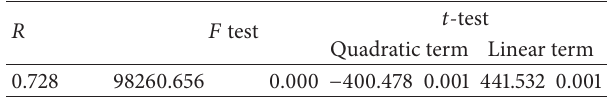
Table 2: Significance test of traffic flow-density quadratic regression model on shoulder lanes. 𝑅 𝐹 test